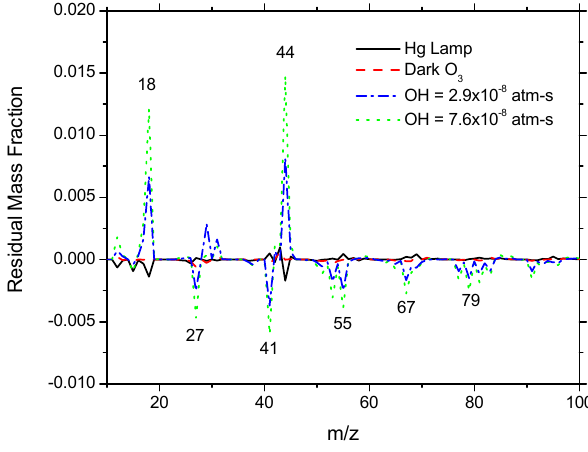
Fig. 2. Difference organic mass spectra of SOA1 for control con- ditions Hg Lamp and Dark O 3 subtracted from Dark mass spec- tra. Mass spectra for SOA exposed to OH were subtracted from Hg Lamp mass spectra. OH exposures are indicated. SOA1 is shown only as an example; similar behavior was observed for SOA2 and